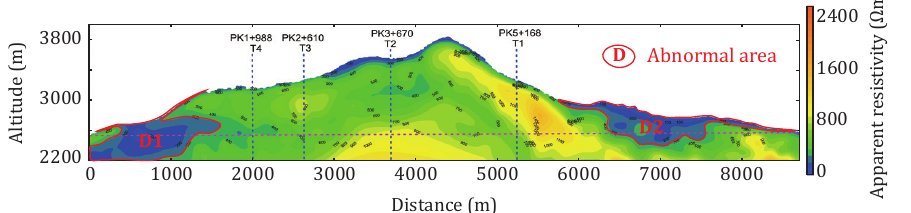
Figure 10. Apparent resistivity imaging result of the parallel pilot tunnel, which is located 35 m southeast of the